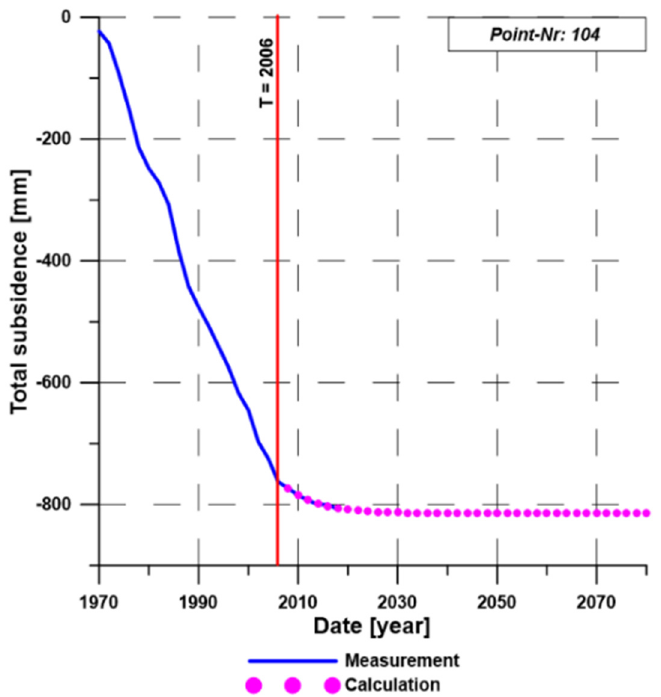
Figure 6. The course of subsidence until 2018 and the prediction of residual subsidence for the point no. 104.